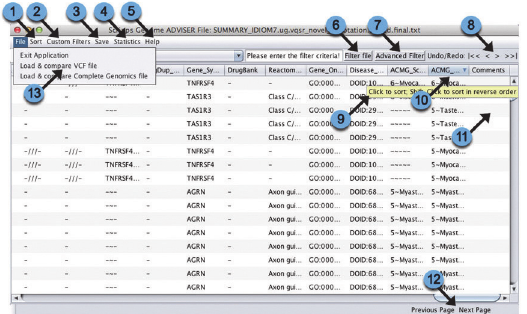
Fig 2. User Interface. The SG-ADVISER user interface provides a number of useful functionalities including: (1) sort the current view by any column; (2) 14 pre-defined custom filters, for example extraction of rare coding variants — for a list of custom filters see http://genomics.scripps.edu/ADVISER/downloads.jsp; (3) post-filtered files can be saved for manipulation outside of the UI; (4) calculation of variant type counts and frequency; (5) a help menu; (6) simple user-defined filter on a single column; (7) advanced multi-column user defined filtering; (8) the capability to move forward and backward through executed filters; (9) extensive tool tips; (10) sorting by clicking the column header; (11) the capability to add and save comments; (12) scrolling through the multiple pages of variants (1000 variants per page); (13) the ability to load in genotype data from the original variant